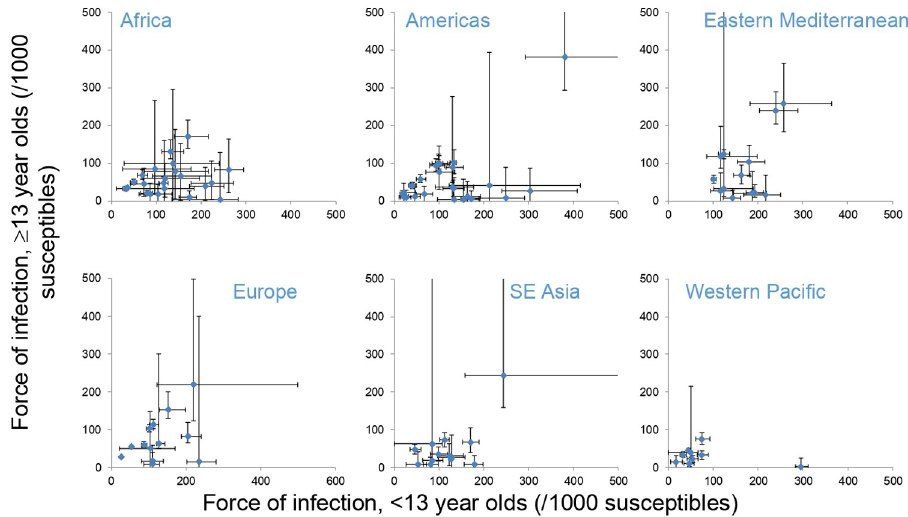
Fig 6. Summary of the force of infection estimates used to calculate the basic reproduction number for each study in each region. The bars reflect the 95% ranges based on bootstrapping.